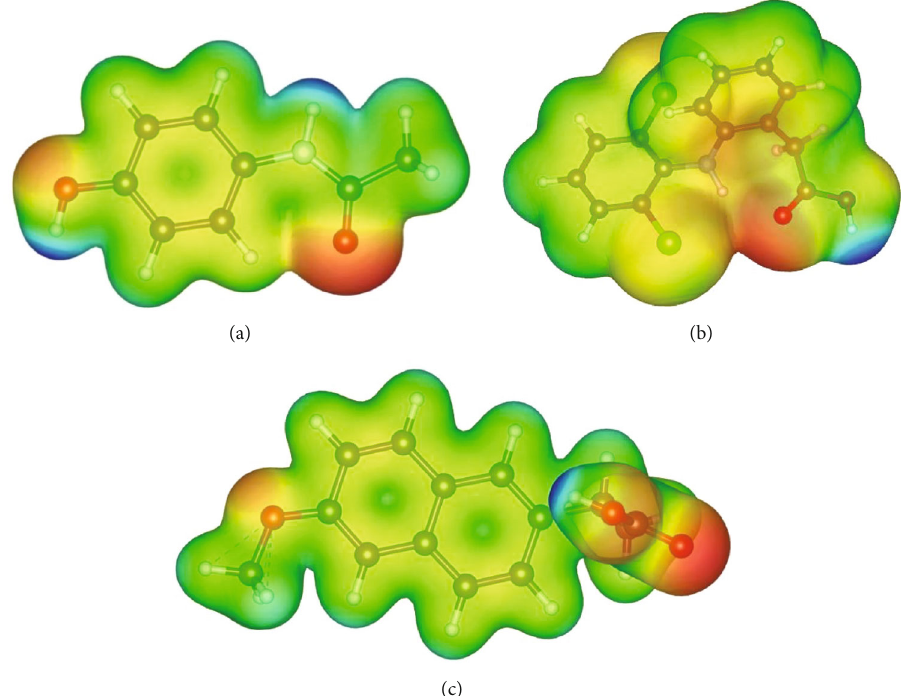
Figure 6: Molecular electrostatic potential of (a) acetaminophen, (b) diclofenac, and (c) naproxen